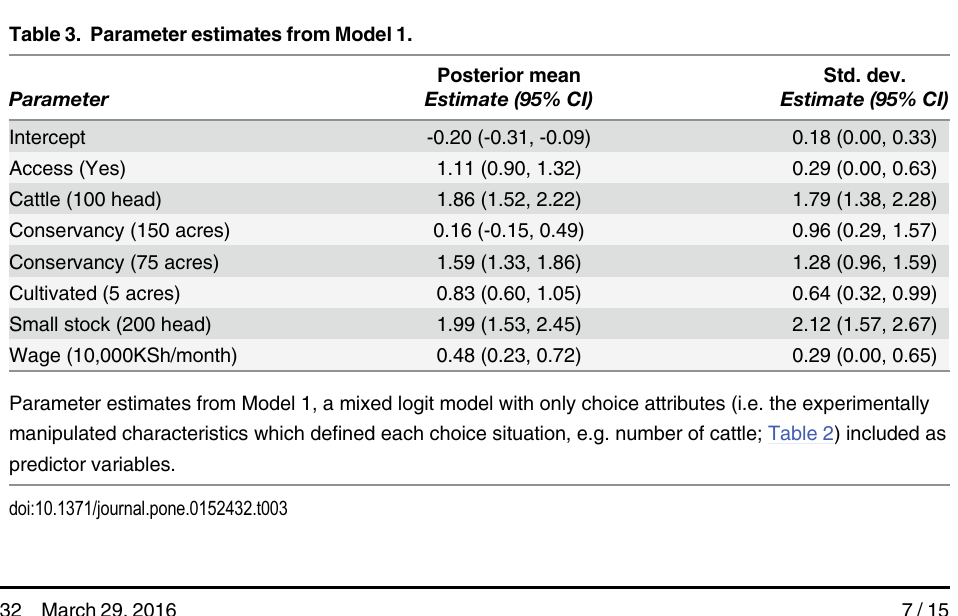
Table 3. Parameter estimates from Model 1. Posterior mean Std. dev. Parameter Estimate (95% CI)